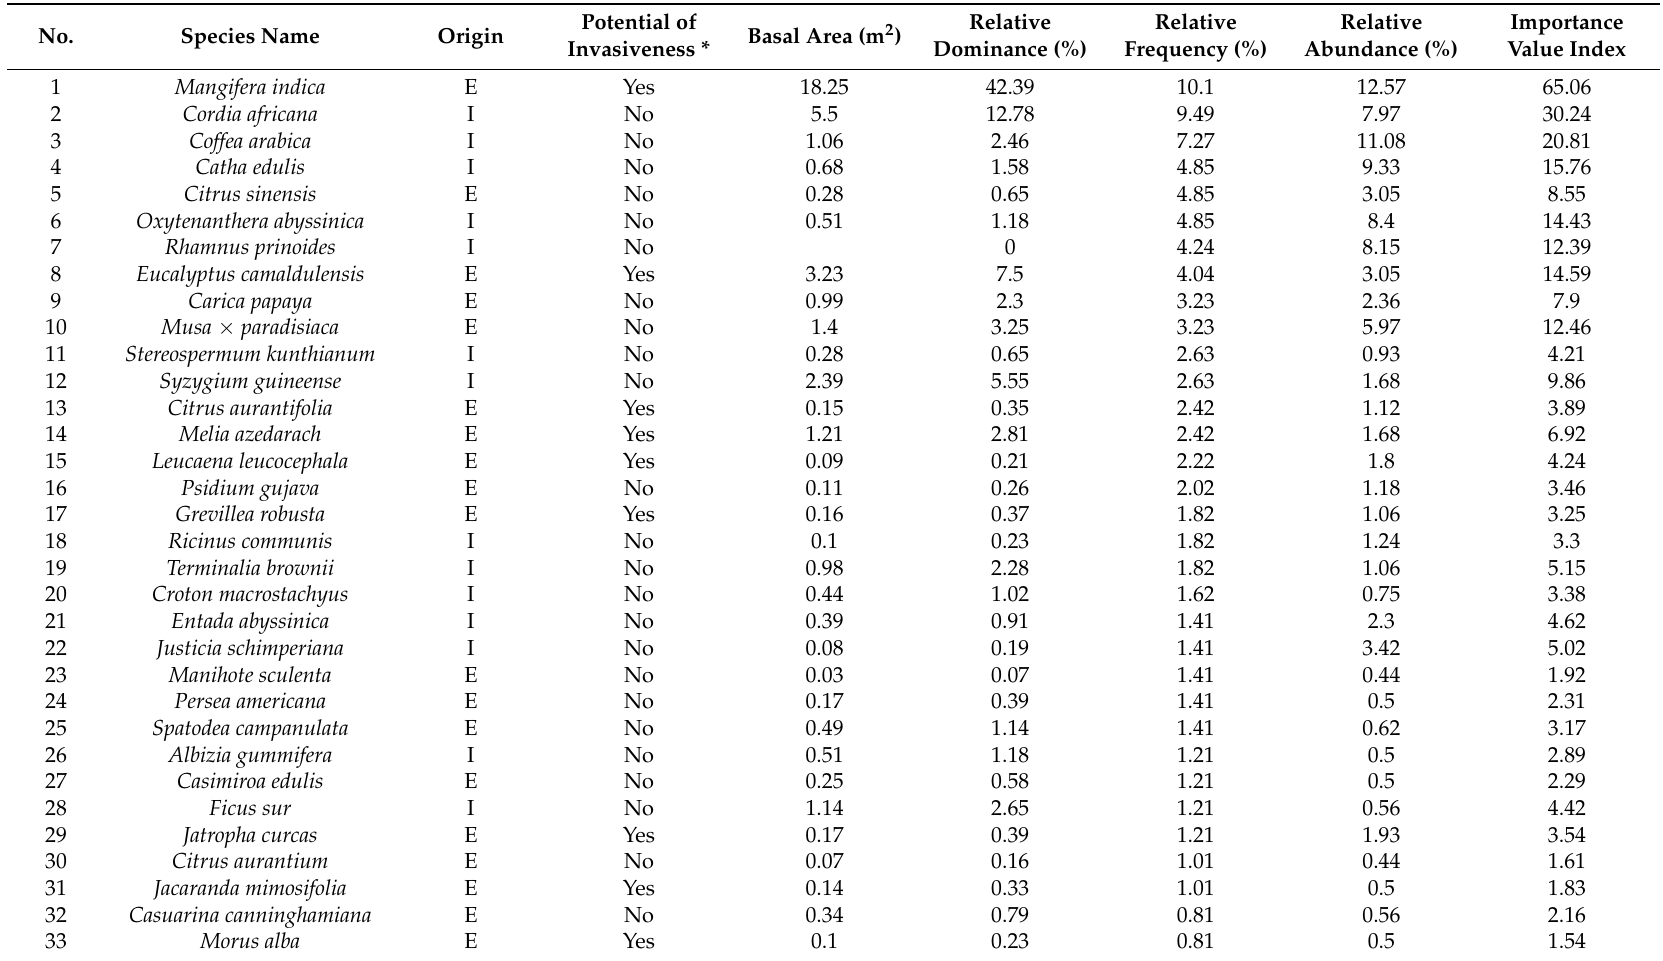
Table A1. Home-garden woody and herbaceous perennial species ordered according to their frequency of occurrence in Assosa district, western